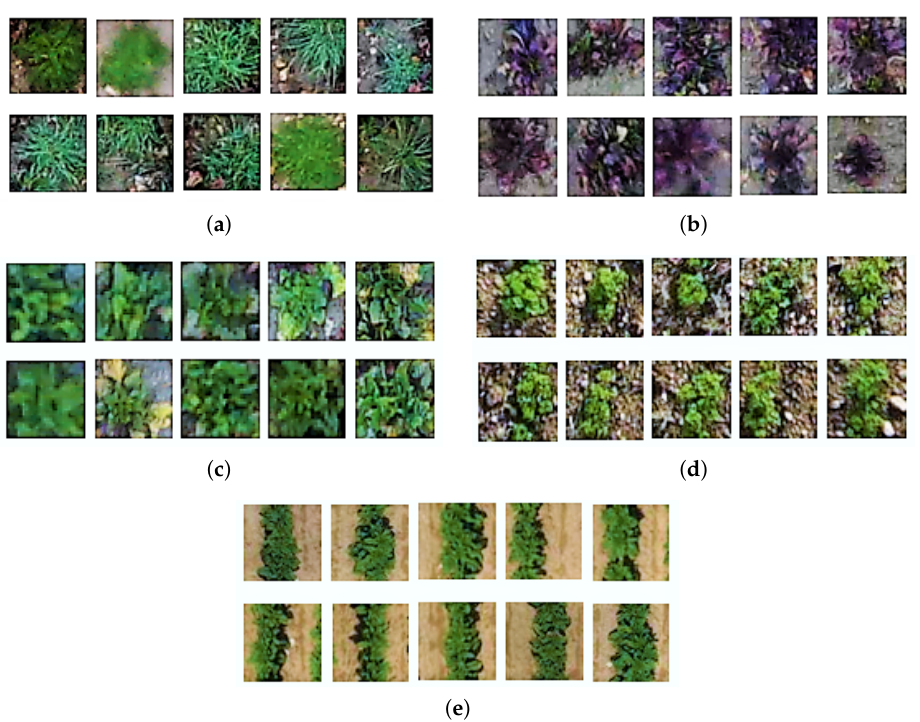
Figure 4. This overview shows sample images patches of all 5 classes of our custom dataset. The images measure 64 × 64 pixels. Each class contains 3200 to 4000 images. ( a ) Weeds; ( b ) Beet; ( c ) Off-type green leaves beet; ( d ) Parsley; ( e ) Spinach.